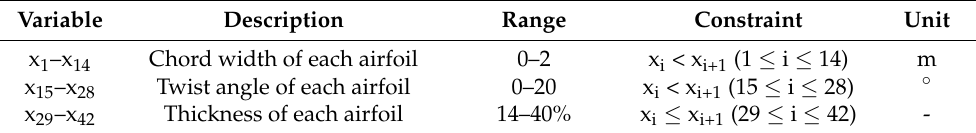
Table 2. Input variables considered in the turbine power production optimisation.